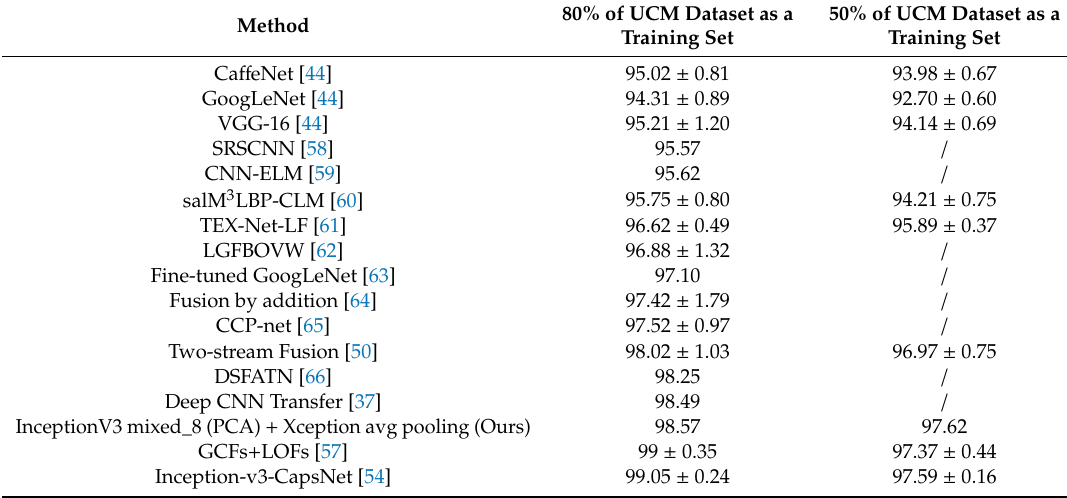
Table 4. The classification accuracy (OA (%) and SD) of the examined method and the reference methods, with 80% and 50% of UC-Merced dataset as a training set.